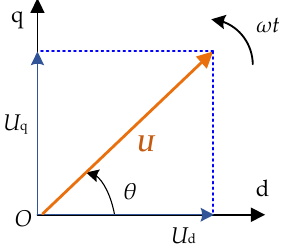
Figure 1. Voltage vector diagram in the dq frame.